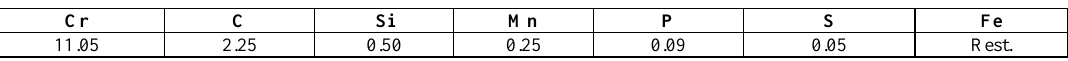
Figure 1. Image of the tool Table 1. Chemical composition of the